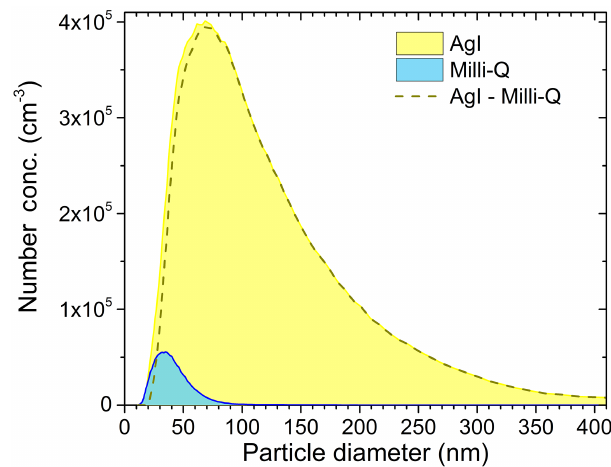
Figure A1. Size distribution of an AgI suspension in Milli-Q wa- ter (yellow area) measured with a scanning mobility particle sizer (SMPS) system (TSI 3936 using a DMA 3081). Pure Milli-Q wa- ter measured with the same method and settings is shown as the blue area. The difference curve area(AgI) – area(Milli-Q) is given as dashed